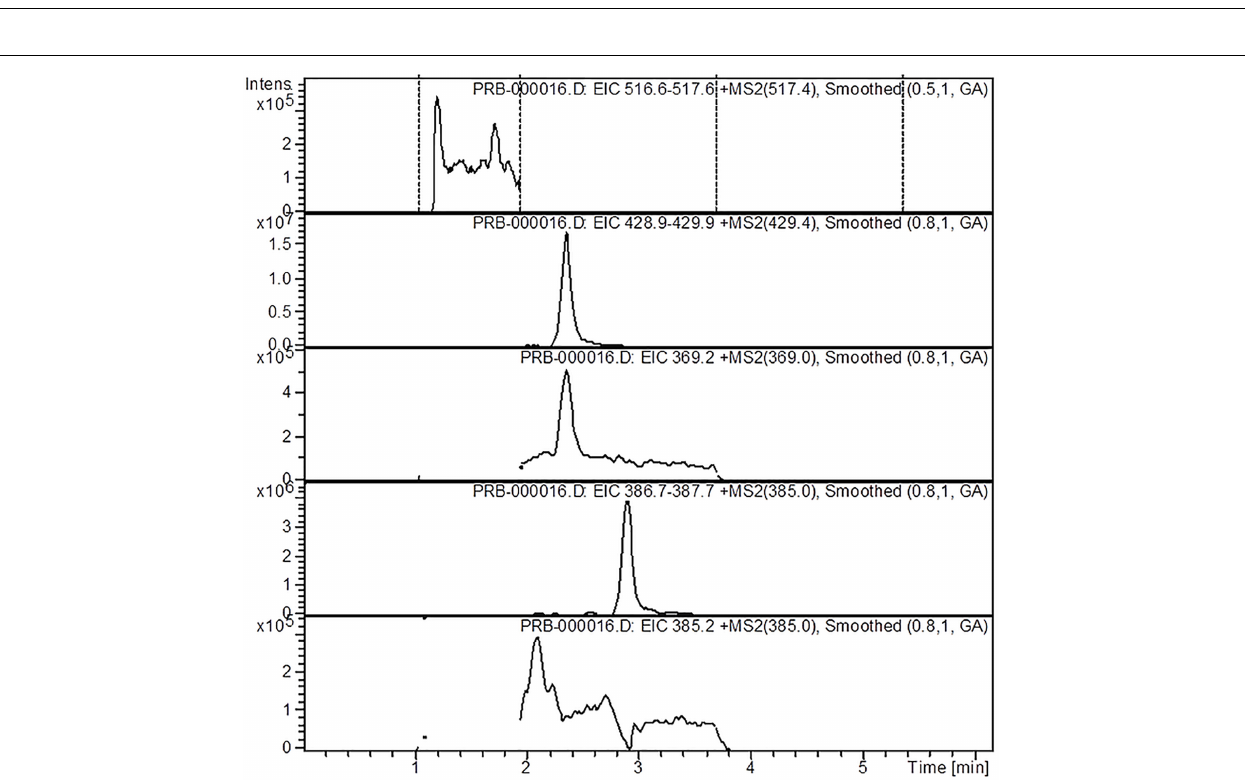
FIGURE 2 | HPLC-MS-MS chromatogram of iridoids from A.genevensis ethanolic extract.